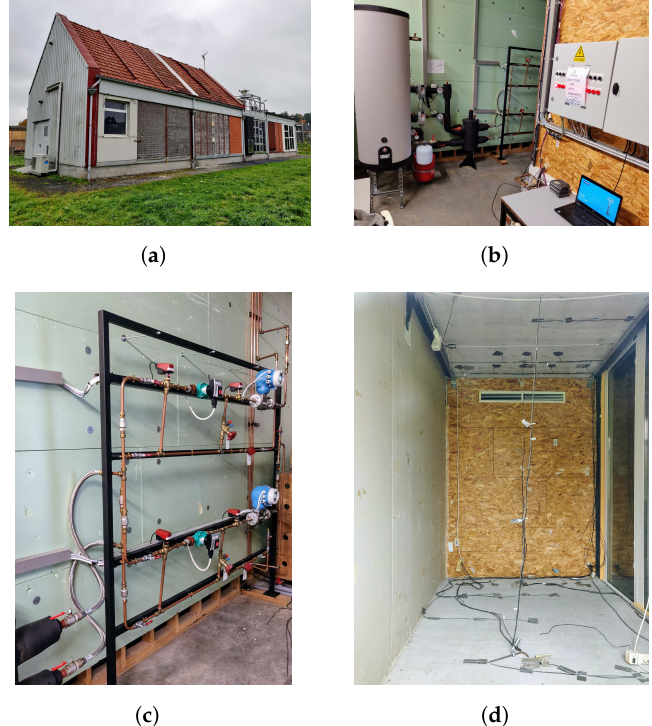
Figure 1. Overview of the Vliet building. ( a ) Building exterior; ( b ) Production system and control setup; ( c ) Distribution system; ( d ) Test room